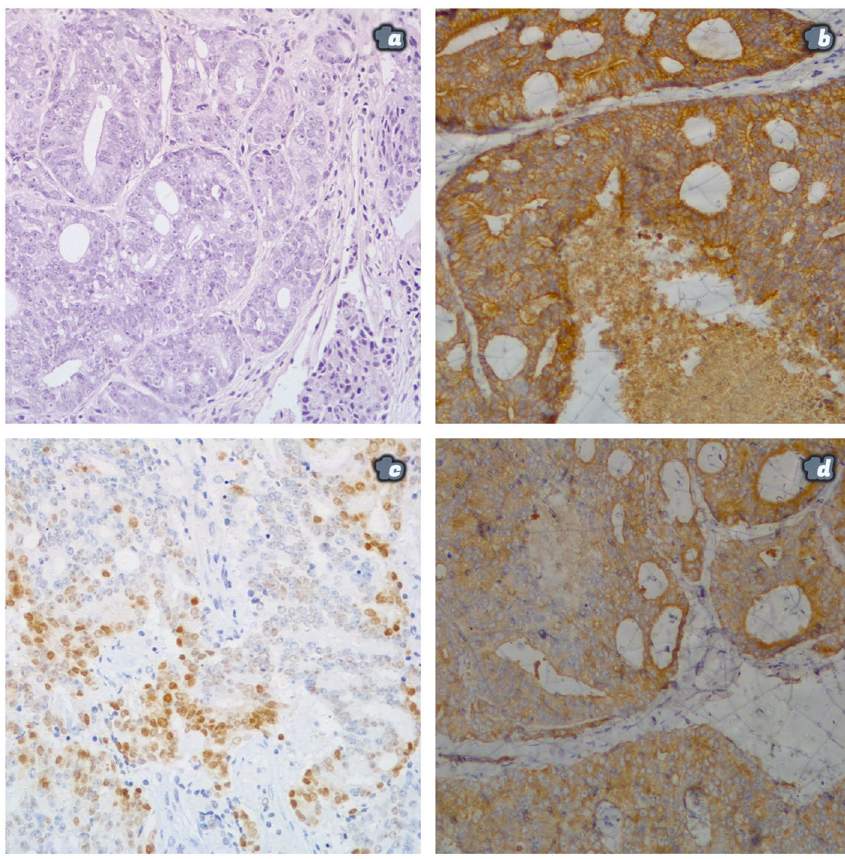
Fig. 1 Histomorphology image of Case 1 shows tumor cells disposed in a cribriform pattern with prominent nucleoli and scant cytoplasm in 1a